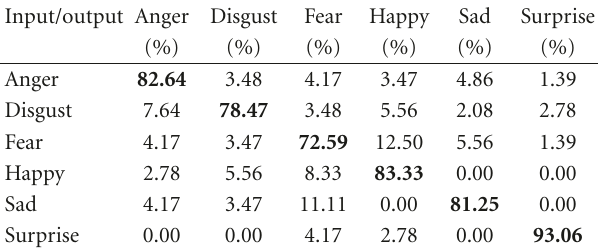
Table 3: Confusion matrix of the LDA classifier the real faces.